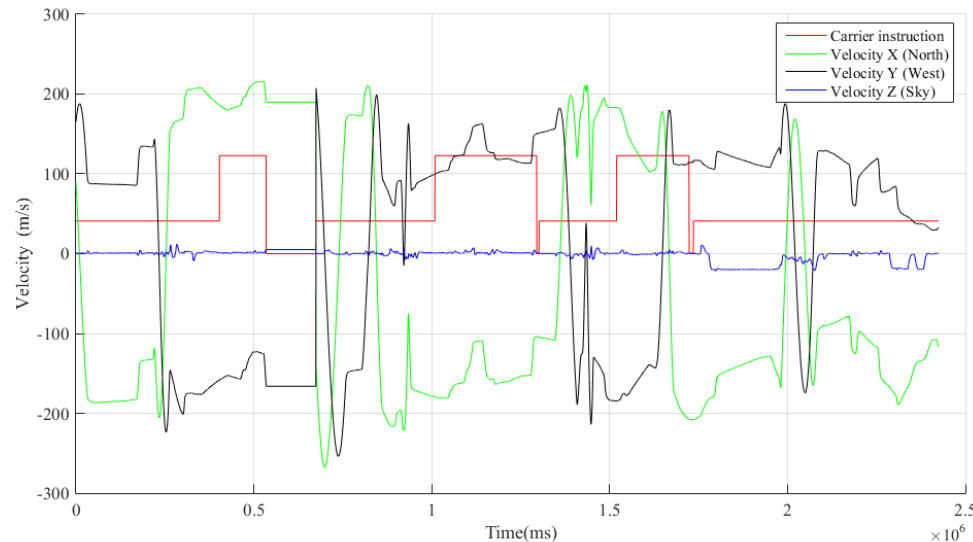
Figure 12. Speed information issued by the carrier to the pod.